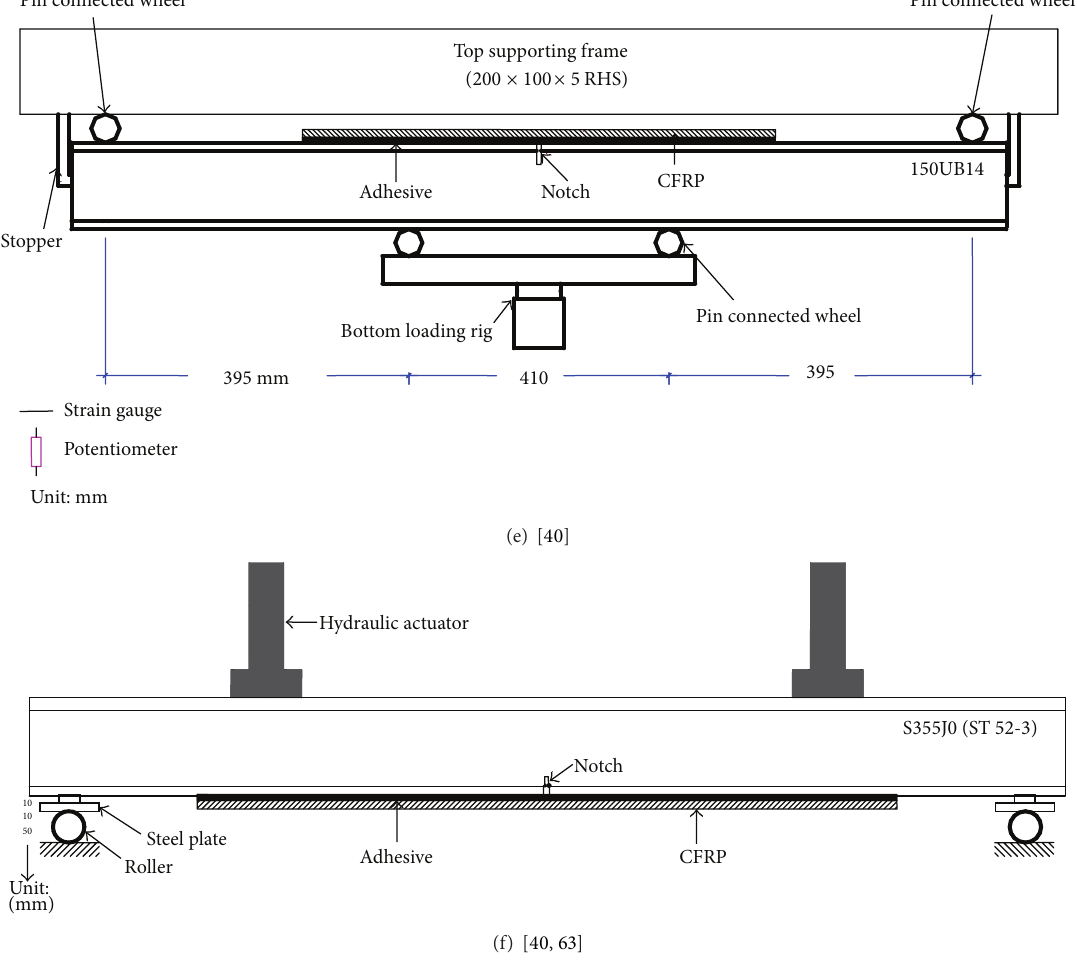
Figure 3: Support condition with fatigue test